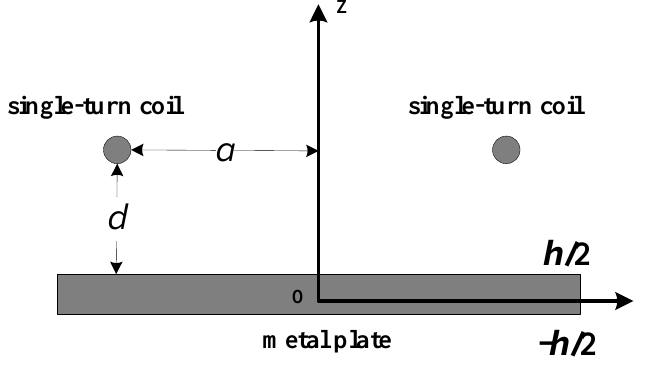
Figure 2. Position distributions of single turn coil and metal plate.